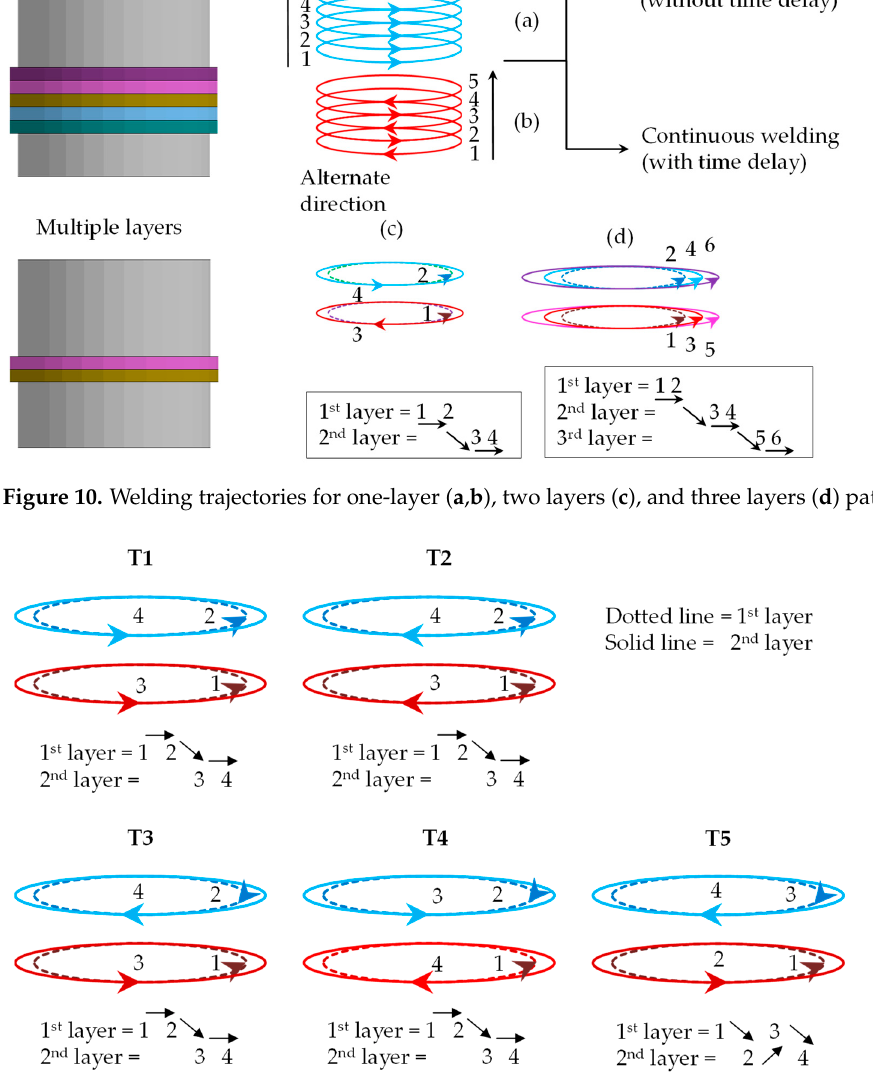
Figure 9. Pattern of the two beads in two layers (2 × 2) ( a ) and two beads in three layers (2 × 3) ( b , c ) on the tool with the A3 beads ( d ).